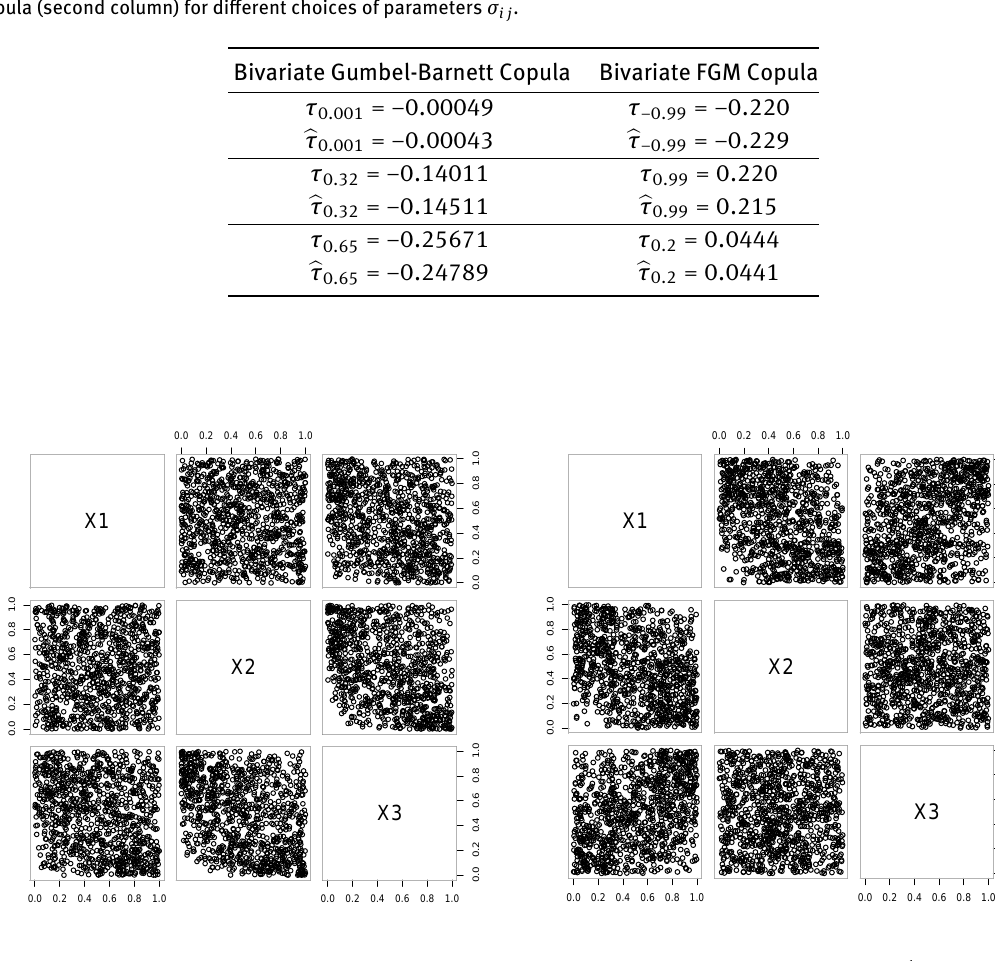
Figure 1: Left : Sample of size n = 1000 from the 3 -dimensional copula C ϕ , G , Σ as in Equation (14) with z ( x ) = 1 2 x , ϕ ( x ) = exp(− x ) and g i ( x ) = ψ ( x ) , i ∈ { 1, 2, 3 } , x ∈ R + . We take σ 12 = 0.001 , σ 13 = 0.32 and σ 23 = 0.65 (see Example 1). Right : Sample of size n = 1000 from the 3 -dimensional copula C ϕ , G , Σ as in Equation (17) with z ( x ) = −ln(1+ x 2 ) , ϕ ( x ) = exp(− x ) and g i ( x ) = 1− x , i ∈ { 1, 2, 3 } for x ∈ R + . We take σ 12 = −0.99 , σ 13 = 0.99 and σ 23 = 0.2 (see Example